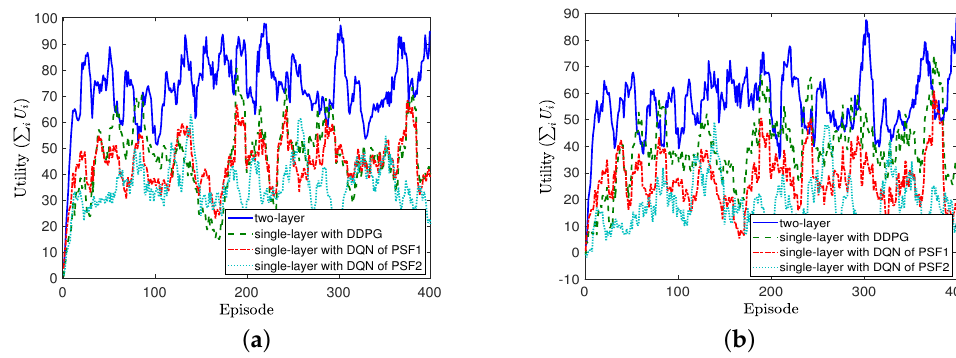
Figure 3. Utilities obtained during training periods upon ( a ) M = 32, and ( b ) M =